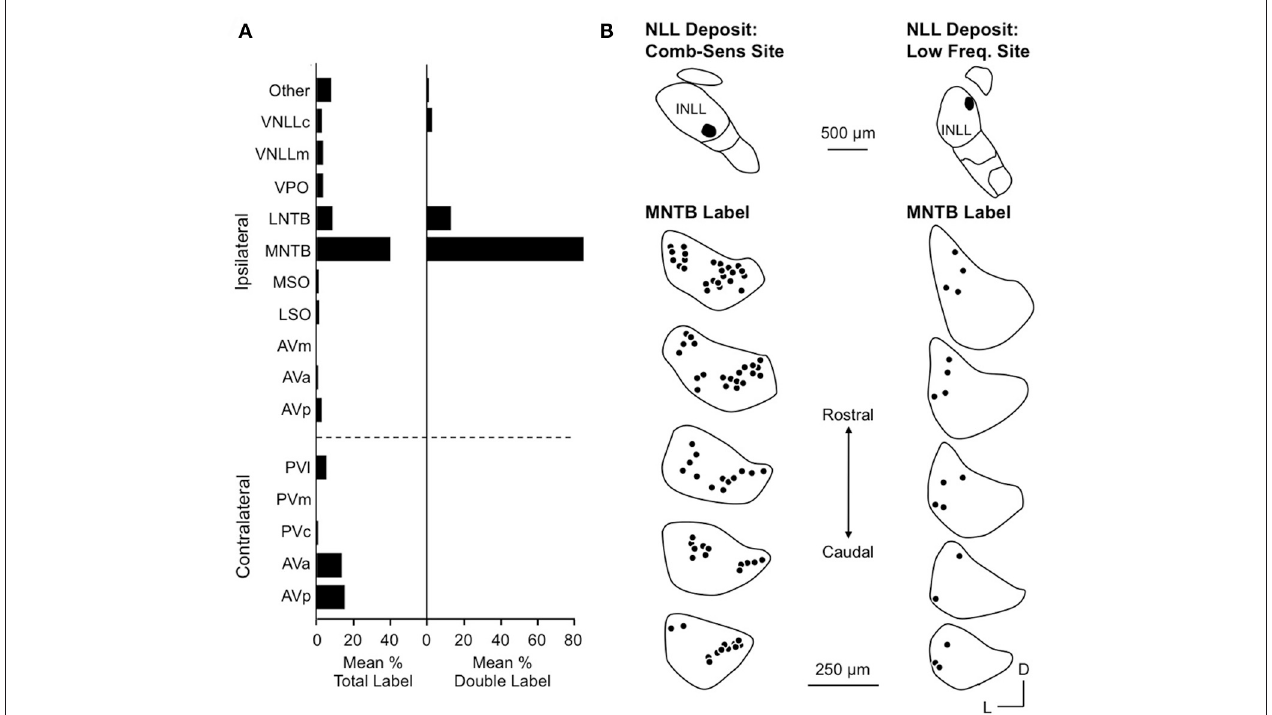
FIGURE 7 | Inputs to INLL neurons that show combination-sensitive inhibition. (A) Left . Distribution of retrograde labeling after INLL deposits in five animals. Right . Distribution of double labeled cells (glycine-immunopositive and retrogradely labeled) after INLL tracer deposits. The ipsilateral MNTB provides the strongest glycinergic input to INLL neurons. (B) Comparison of retrograde label in MNTB after INLL deposits at